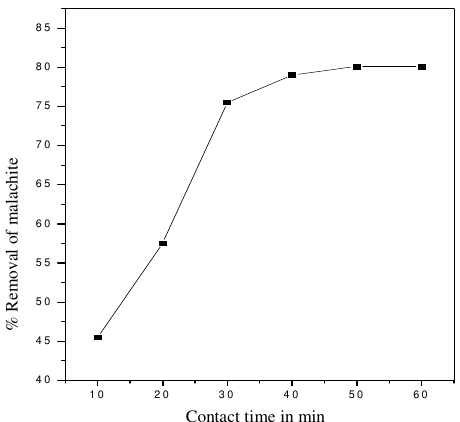
Figure 3 . Linear Langumir isotherm for the adsorption of malachite green onto ZDC